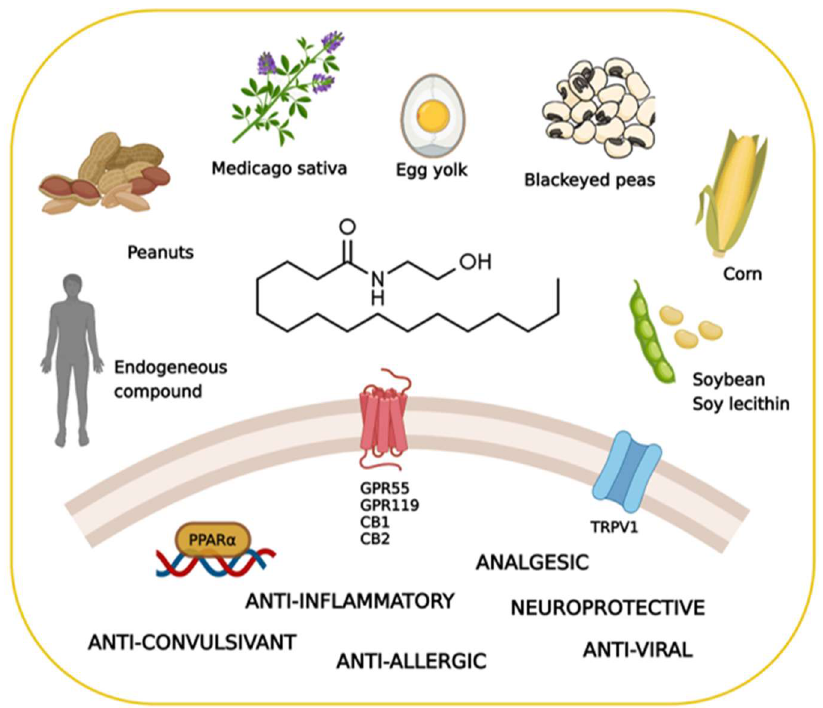
Figure 1. Key facts on palmitoylethanolamide (PEA), including its main sources, molecular targets, and effects. Created with BioRender.com (accessed on 22 July 2022).